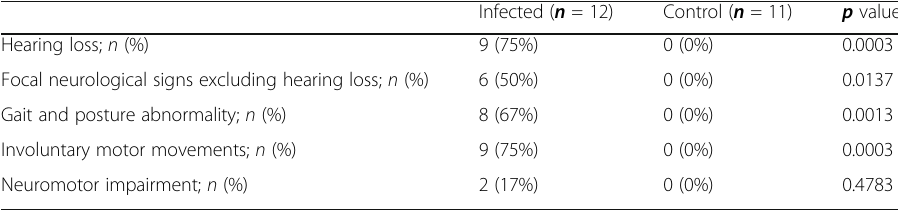
Table 3 Incidence of any neurological symptoms with score ≥ 2 at day